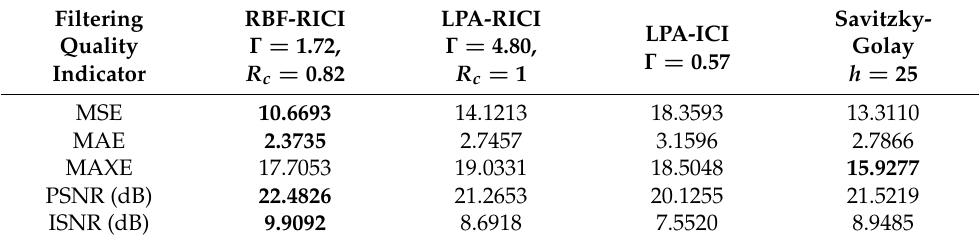
Table 29. Piece-Regular signal (SNR = 5 dB)—Filtering